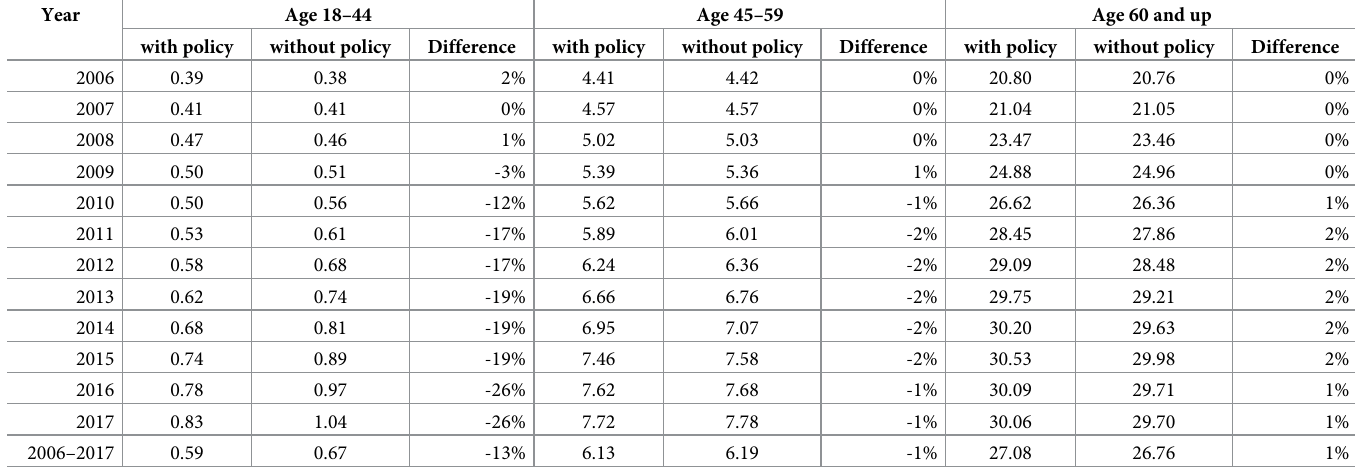
Table 4. Average monthly AMI hospitalization rates per 100,000 population by age groups with and without policy on cigarette tax and smokefree